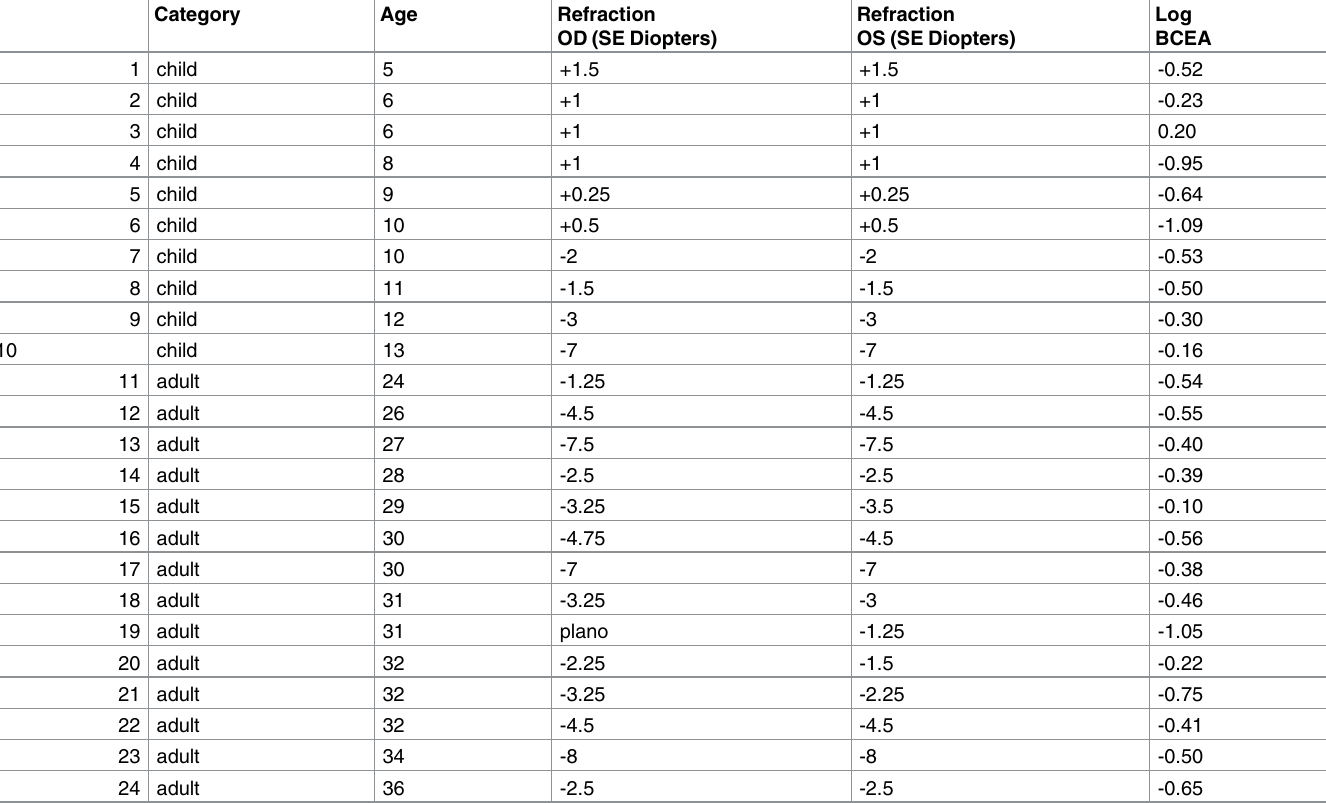
Table 1. Demographics and log BCEA of fixation data of all the study